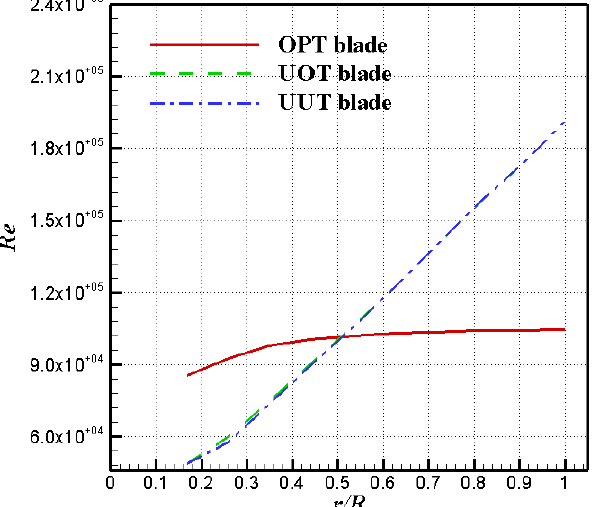
Figure 2. The distributions of Reynolds number in each section at V = 10 m/s and λ = 5.